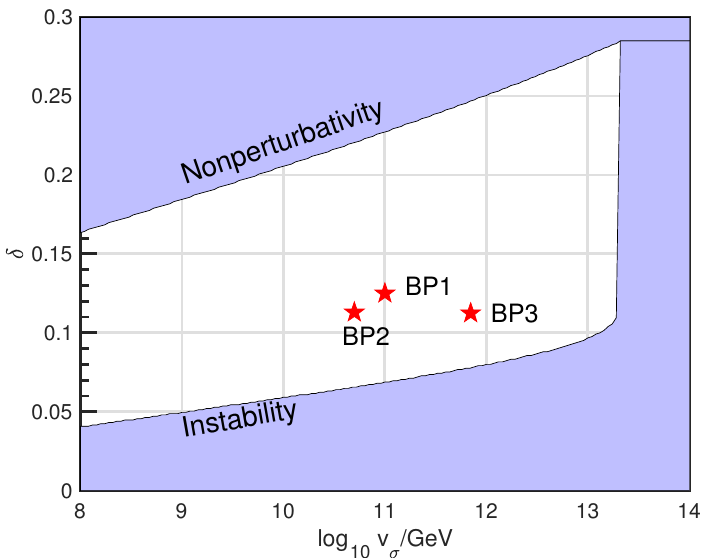
Figure 8. The available parameter space is consistent with a stable vacuum in ( v σ , δ ) space. λ σ is fixed, while λ H σ is determined by Equation (13) and m ρ by Equation (9). We have denoted our benchmark points with a red